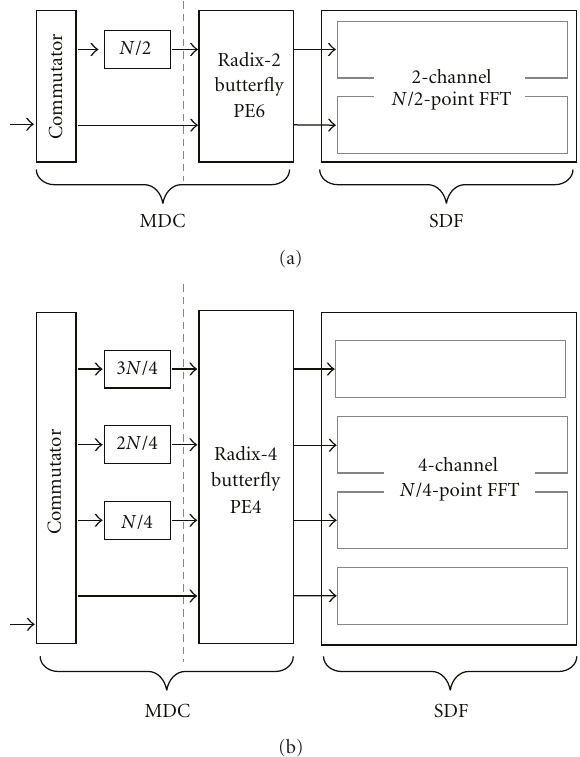
Figure 1: (a) Architecture of an FFT processor with parallelism degree of two. (b) Architecture of an FFT processor with parallelism degree of